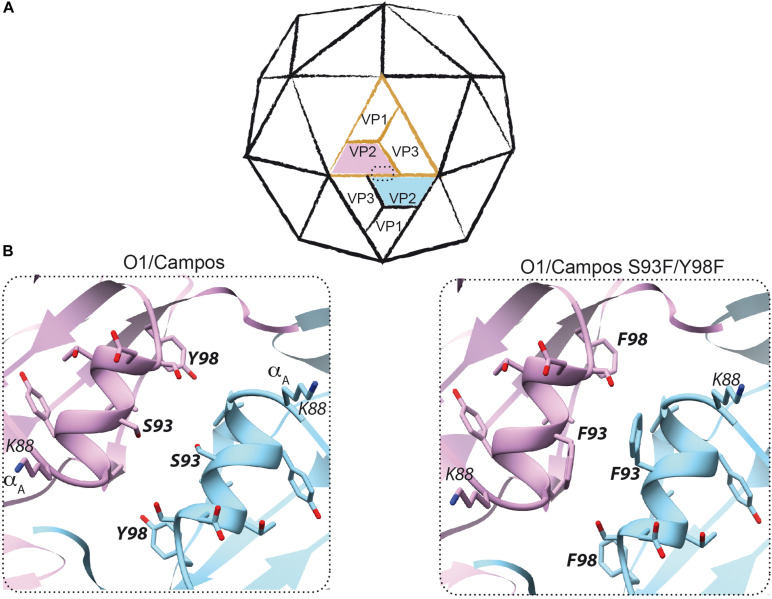
Rational design to produce empty capsids of foot-and-mouth disease virus (FMDV) O1/Campos. (A) Scheme of the icosahedral FMDV capsid. A protomer consisting of VP1, VP2, VP3, and the internal polypeptide VP4 (not visible) is shown in orange. The interface between two pentamers at the two-fold symmetry axis, where two neighboring VP2–VP2 interact, is enclosed within a dashed rectangle. (B) The VP2 structure of FMDV O1/Campos was modeled as described in the section “Materials and Methods”. This model led to the prediction and potential localization of residues S93 and Y98, located on the α-helix A (amino acids K88–Y98) at the two-fold symmetry axis.